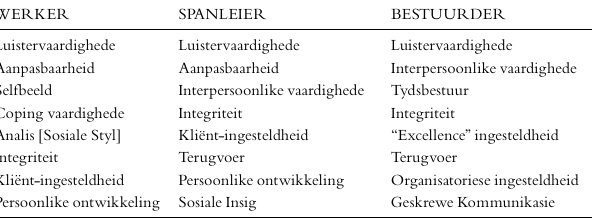
Figuur3: DiedimensiesvirdieverskillendeposvlakkesoosgeselekteerdeurdieJSI-komitee (’nVolledige beskrywing van elke dimensie is beskikbaar in die CSIP